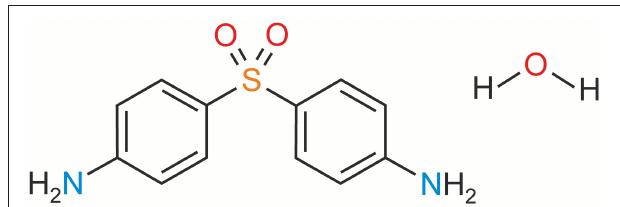
FIGURE 1 | Molecular diagram of 4,4 ′ -diaminodiphenyl sulfone (DDS, dapsone)